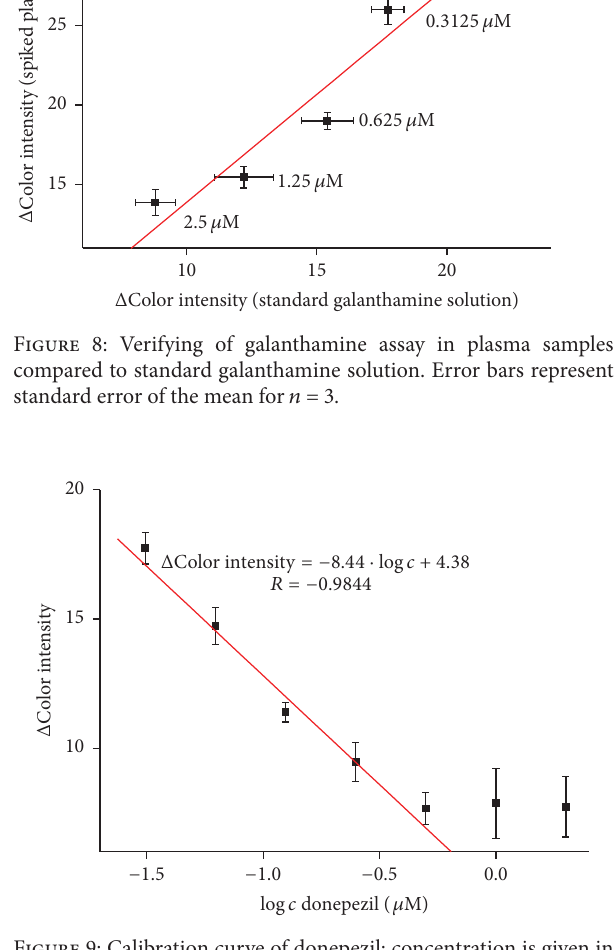
Figure 9: Calibration curve of donepezil; concentration is given in logarithm. Error bars represent standard error of the mean for 𝑛 = 3.